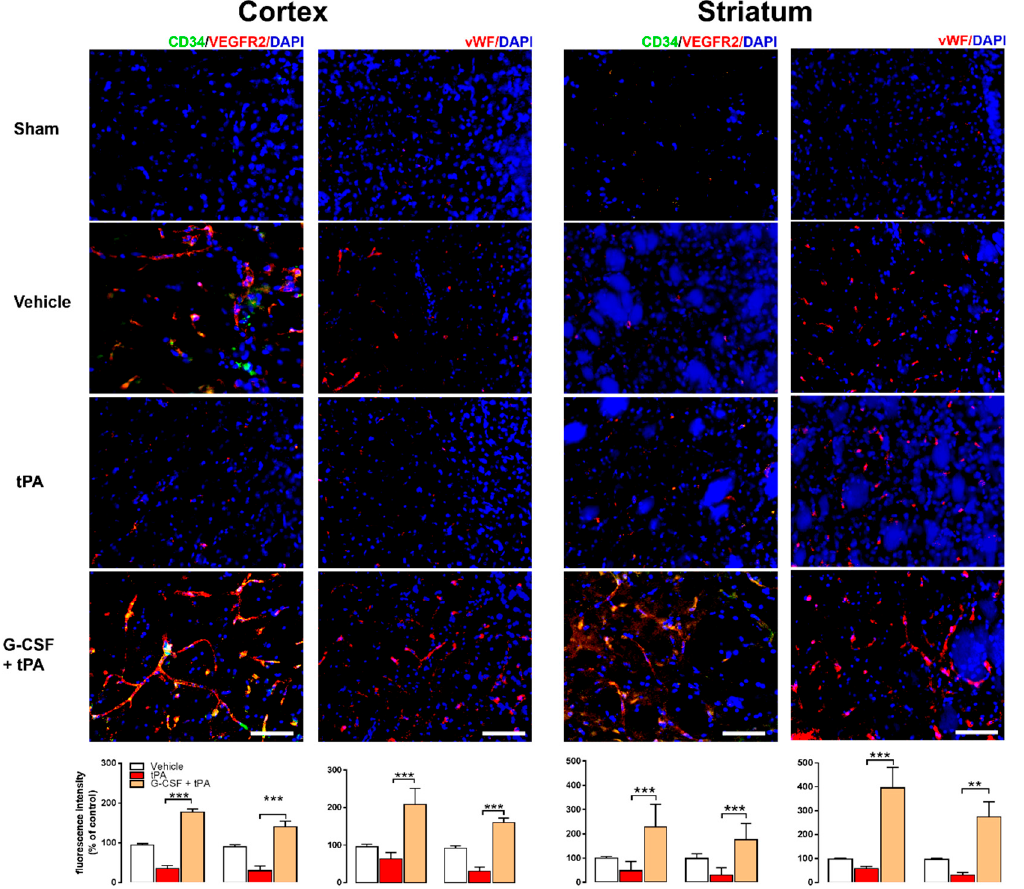
Figure 3. Immunohistochemical analyses of endothelial progenitor cell (EPC) markers CD34+ and VEGFR2 and of the vasculogenesis marker vWF in the ischemic cortex and striatum. Representative merged images obtained 3 days after stroke show co-localization of CD34+ and VEGFR2 or vWF with 4 ′ ,6-diamidino-2-phenylindole (DAPI; blue filter, nuclear staining). Analysis of fluorescence intensities showed that G-CSF treatment increased the expression of CD34+ and VEGFR2 in the ischemic cortex by 1.8- and 1.5-fold (vs. control) 3 and 7 days, respectively, after stroke. G-CSF also increased CD34+ and VEGFR2 expression in the ischemic striatum by 2.27- and 1.8-fold (vs. control) 3 and 7 days, respectively, after stroke. vWF expression was markedly increased by 2- and 1.7-fold (vs. control) in the ischemic cortex 3 and 7 days, respectively, after stroke. vWF expression was also enhanced by 4- and 2.8-fold (vs. control) in the ischemic striatum of G-CSF-treated animals 3 and 7 days, respectively, after stroke; ** p < 0.01, *** p < 0.001, n = 6 rats per group. The data are expressed as mean ± S.E.M. Horizontal bar: 100 µ